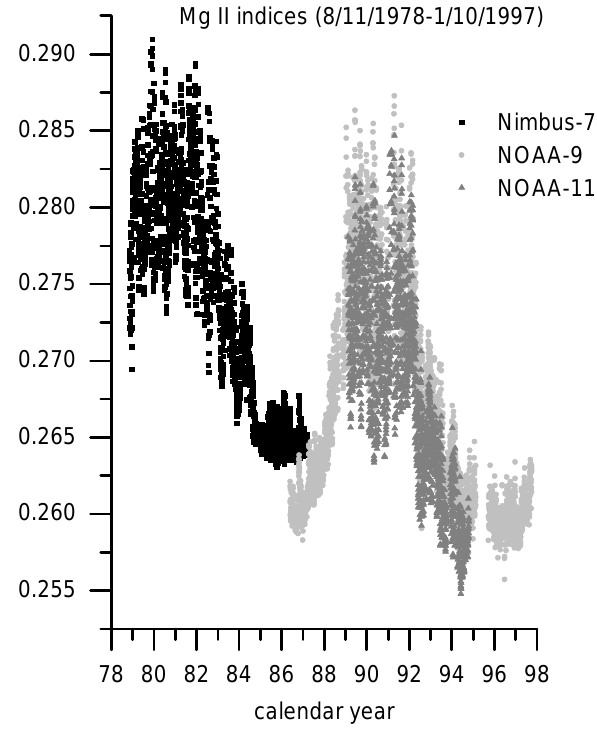
Fig. 2. The corrected for instrumental drift original Nimbus-7, NOAA-9 and NOAA-11 Mg II indices